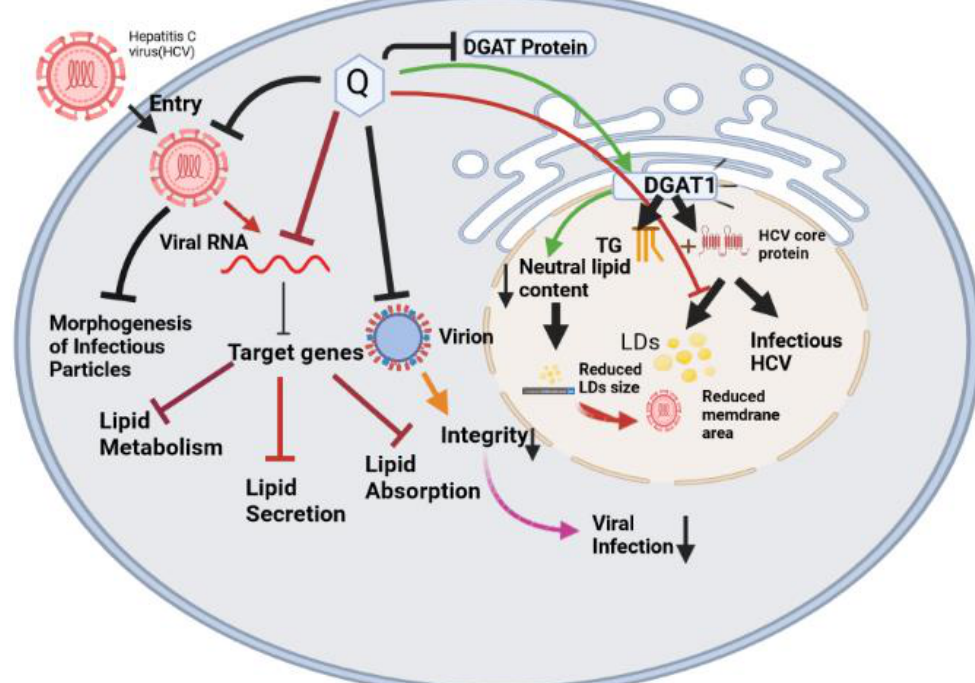
Figure 3. Effects of Quercetin in reducing the membrane area of Hepatitis C virus. The Hepatitis C virus entered the cellular system and is finally weakened through the protein molecule Diglyceride acyltransferase (DGAT, subtype DGAT1), which is inhibited by the administration of Quercetin. Inhibited DGAT downregulates the lipid synthesis, HCV core protein is eventually neutralized through the reduction of lipid droplets (LDs) size, which decreases the membrane size for HCV. HCV infections become attenuated.